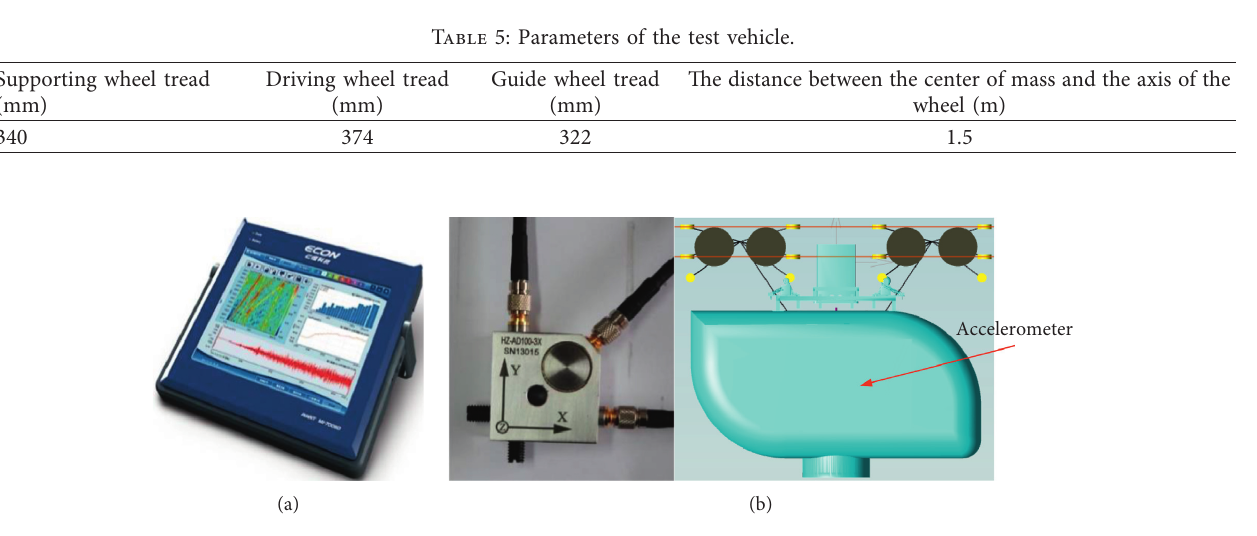
Figure 26: Measurement system. (a) Acquisition system. (b) Sensor position.